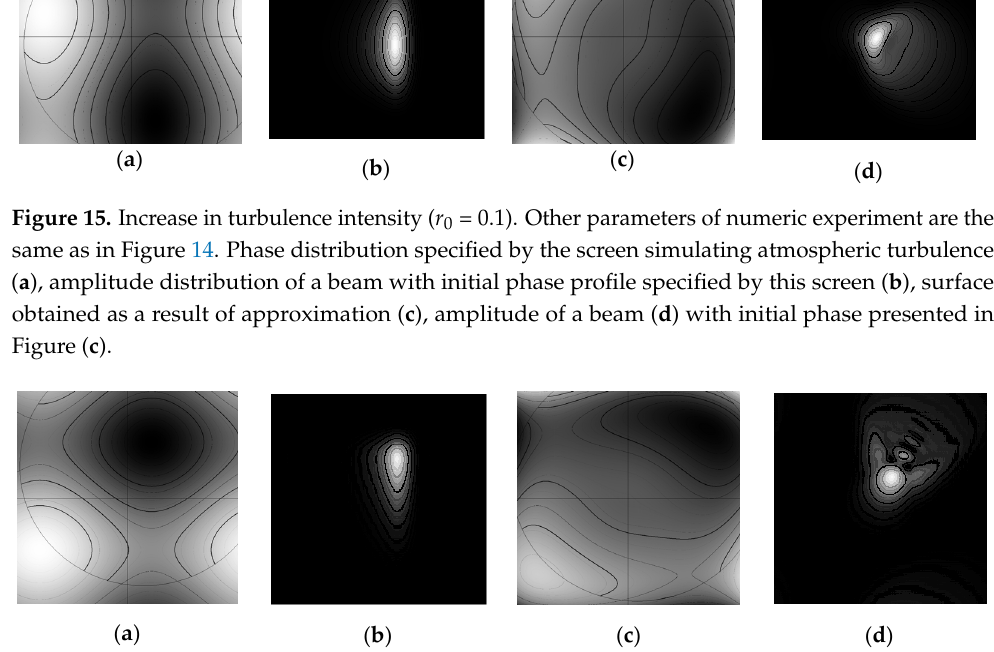
Figure 14. Precision of phase screen approximation. Phase distribution specified by the screen simulating atmospheric turbulence ( a ), amplitude distribution of a beam with initial phase profile specified by this screen ( b ), surface obtained as a result of approximation ( c ), amplitude of a beam ( d ) with initial phase presented in Figure ( c ). Dimensions of computation grid are 1024 × 1024, r 0 = 0.2. Table 6. Characteristics of the beam in the plane of observations. Parameters of numeric experi- ment were the same as in the previous example (Figure 14).